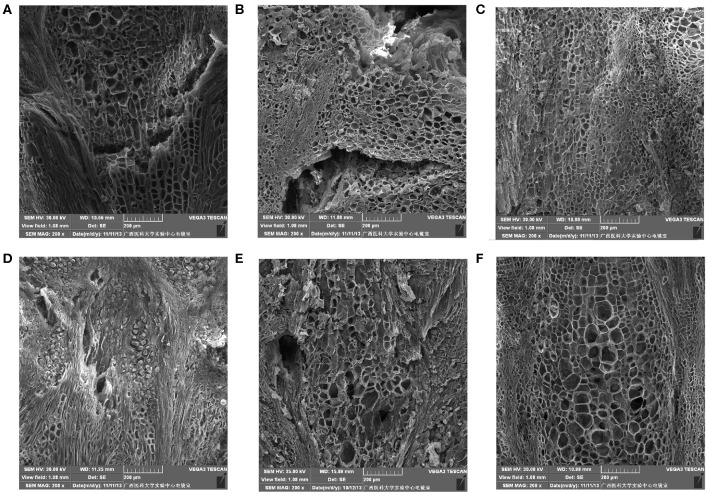
The ultrastructure of stalk–berry junction cells of table grapes after storage for 0 or 6 days (×200). After storage for 0 day in “Muscat Kyoho” (A), “Kyoho” (B), and “Nanyu” (C); after storage for 6 days in “Muscat Kyoho” (D), “Kyoho” (E), and “Nanyu” (F). All images are of transverse sections.